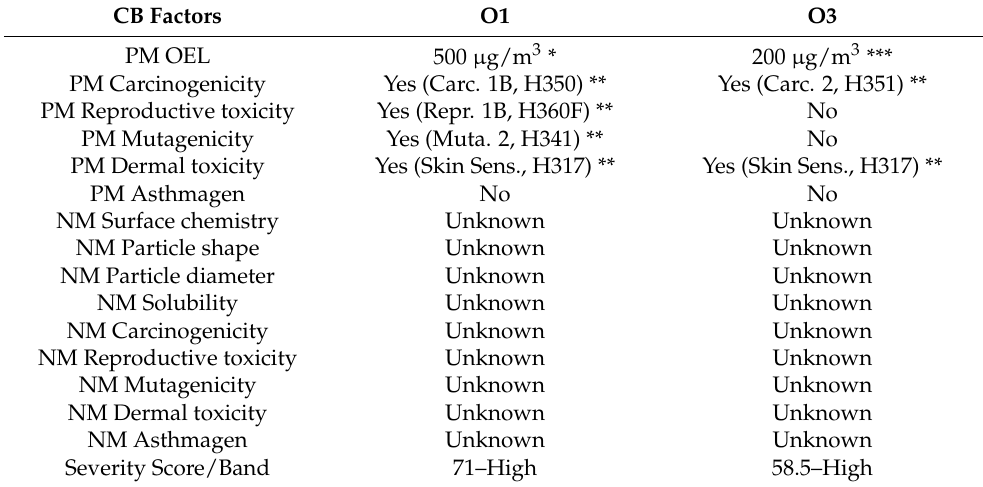
Table 7. Severity scores of O1 and